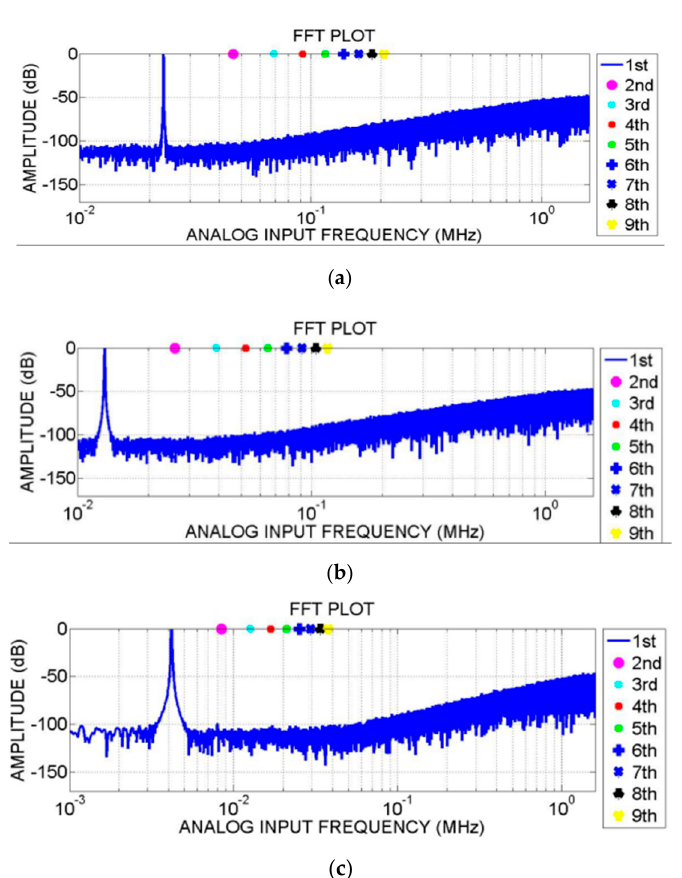
Figure 14. Output power spectrum of the modulator at different input frequencies. ( a ) Spectrum output of the modulator at 23 K input frequency. ( b ) Spectrum output of the modulator at 13 K input frequency. ( c ) Spectrum output of the modulator at 5.1 K input frequency.